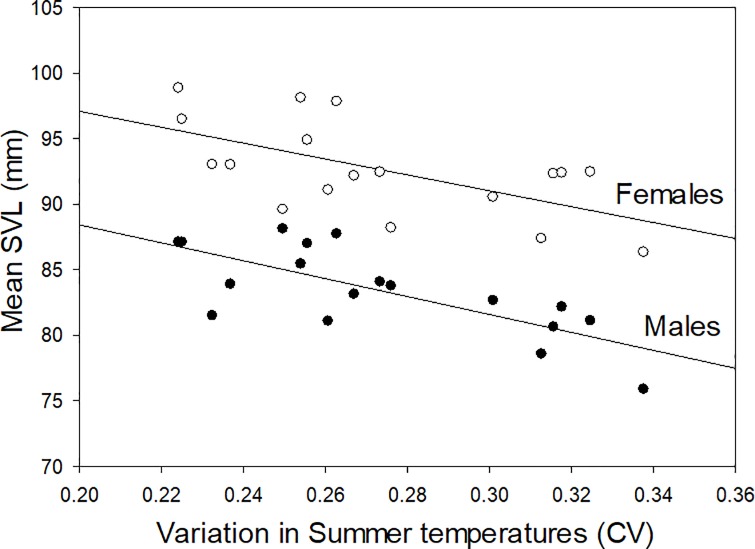
Relationship between the coefficient of variation in minimum previous summer temperatures and the snout-vent length (SVL) of migrating adults.Regression lines are shown for males (closed circles) and females (open circles).